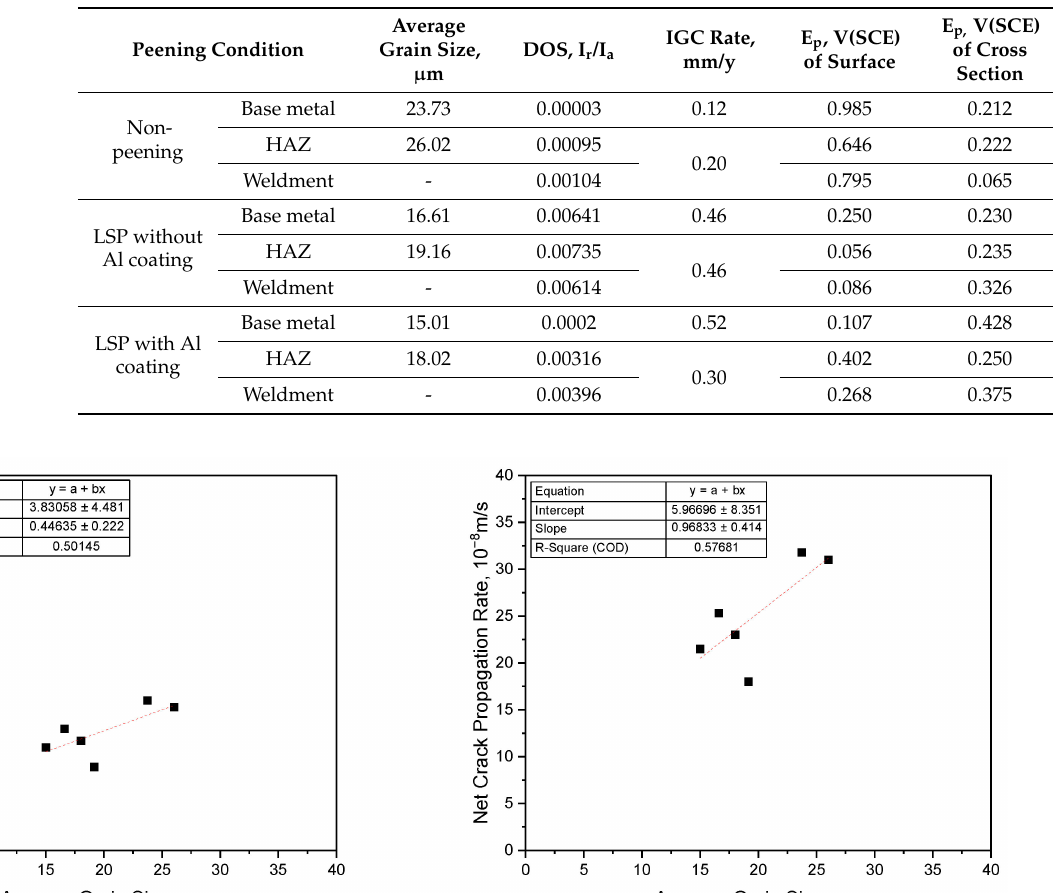
Table 5. Peening effect on average grain size and corrosion properties of 304L base and welded metals [36,37].